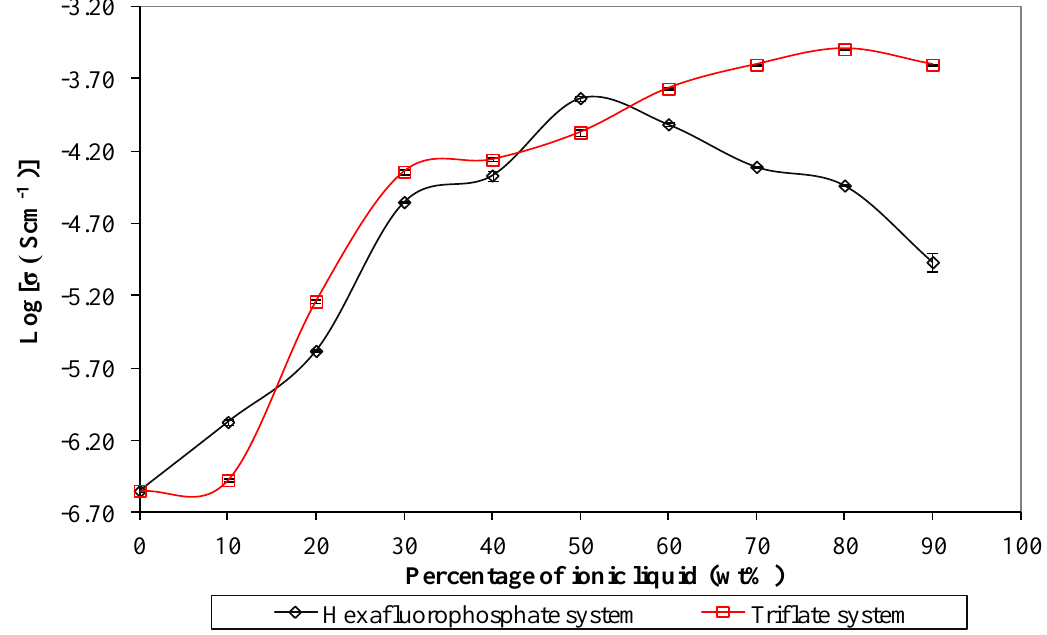
Figure 1. Ionic conductivity of ionic liquid-based biopolymer electrolytes with respect to the mass fraction of ionic